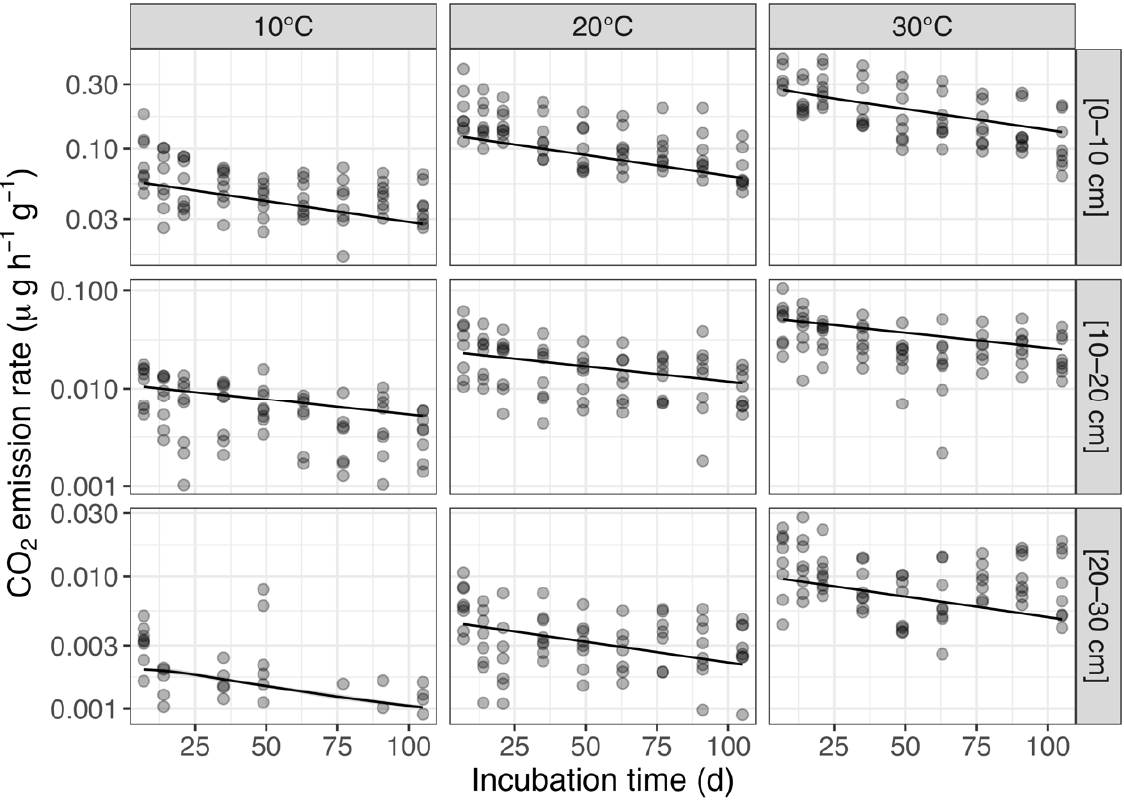
Figure 3 . Influence of soil layer, temperature and time on CO 2 emission rate.